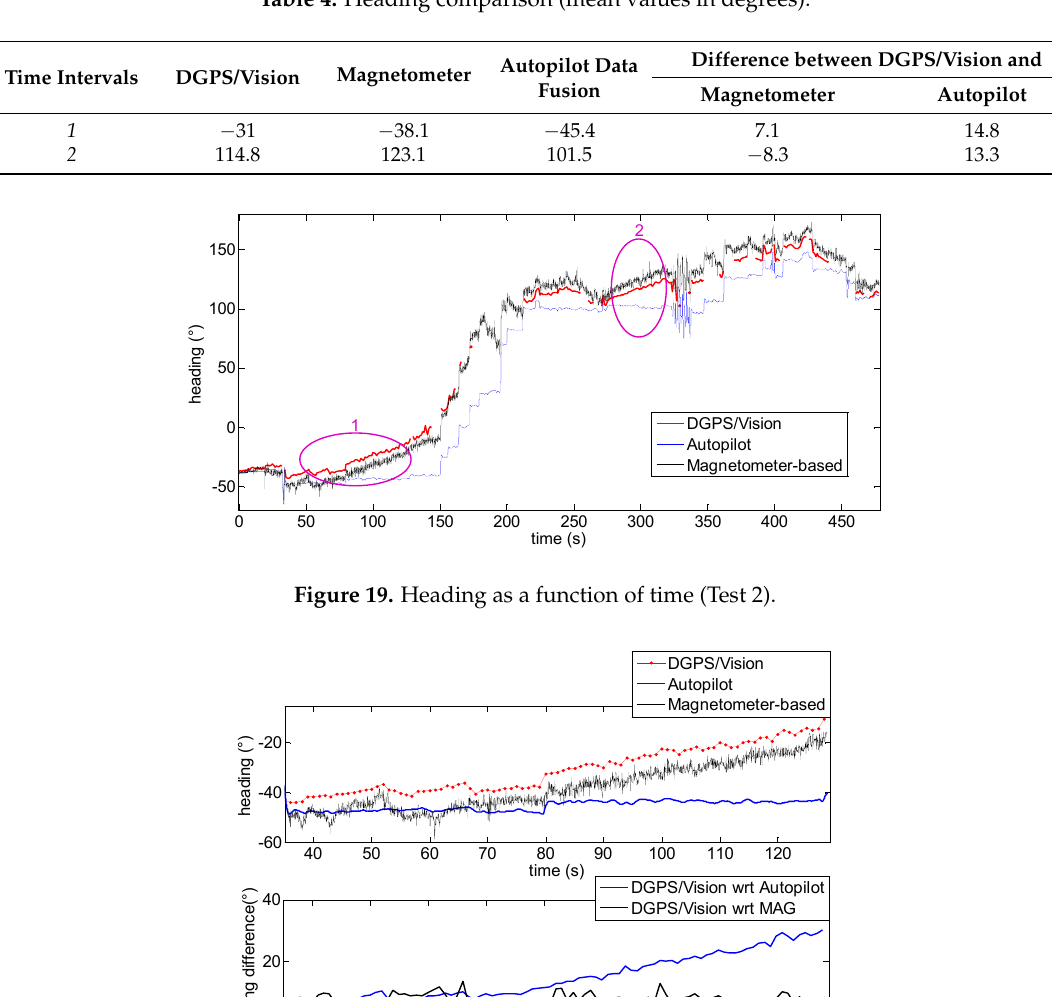
Table 4. Heading comparison (mean values in degrees).